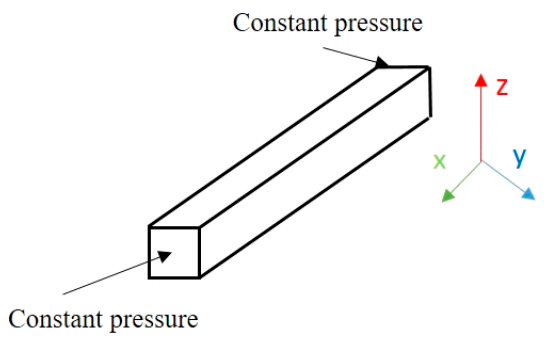
Figure 2. Simulation setup for phase equilibrium in a single capillary tube.